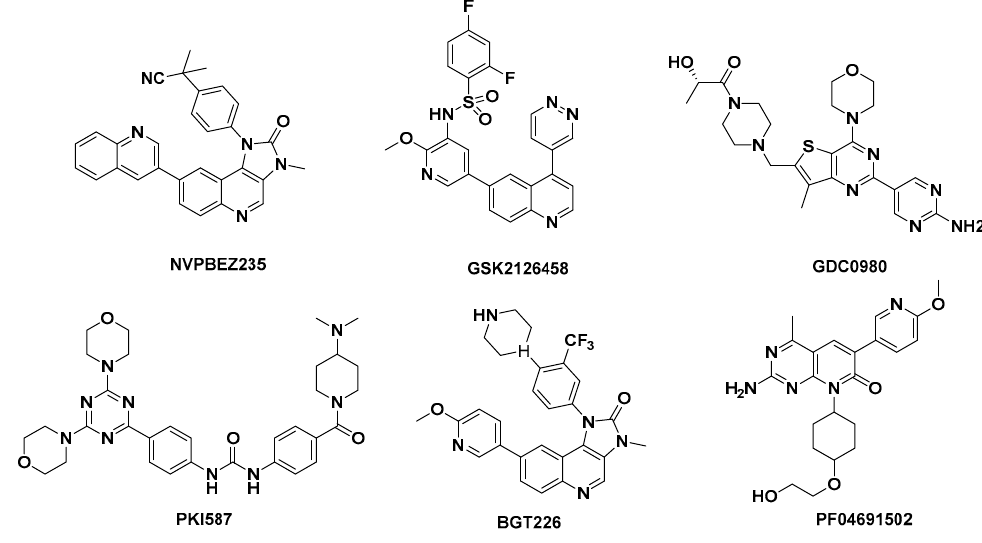
Figure 1. Structures of representative clinical PI3K/mTOR dual inhibitors.